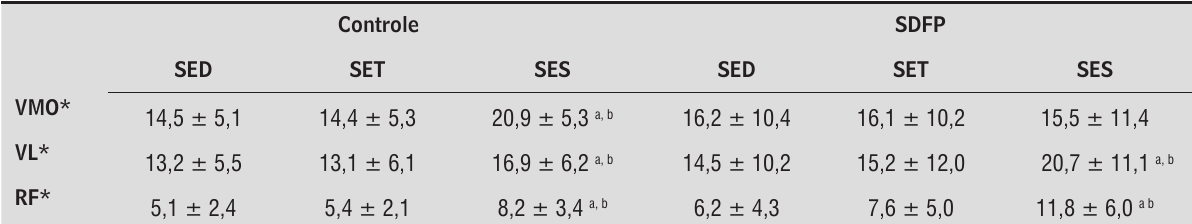
Tabela 1 - Atividade EMG normalizada ( % RMS) dos músculos vasto medial oblíquo, vasto lateral e reto femoral durante a tarefa de subir escada utilizando tênis, salto e estando descalço para o grupo controle e SDFP